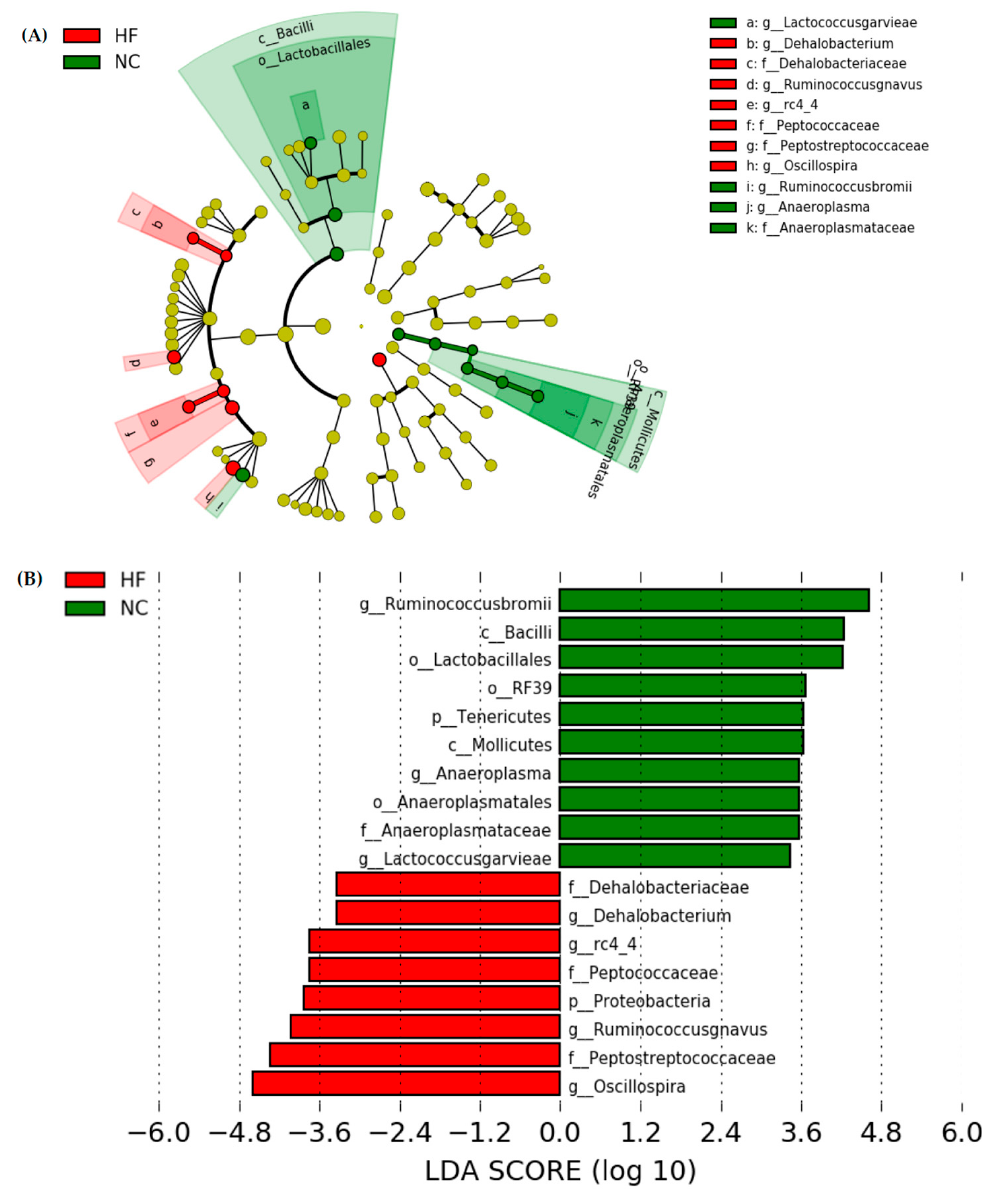
Figure 12. Effects of the water extract of fermented rice bran (FRB) on taxonomies of fecal microbiotic compositions in aged rats with high-fat (HF) diet feeding. ( A ) A linear discriminant analysis of the effect size (LEfSe) of the most significant abundance differences in the fecal microbiota in the NC and HF groups ( n = 5). ( B ) Bacteria meeting the LDA threshold ( ≥ 2) differed in the NC and HF groups ( n = 5).